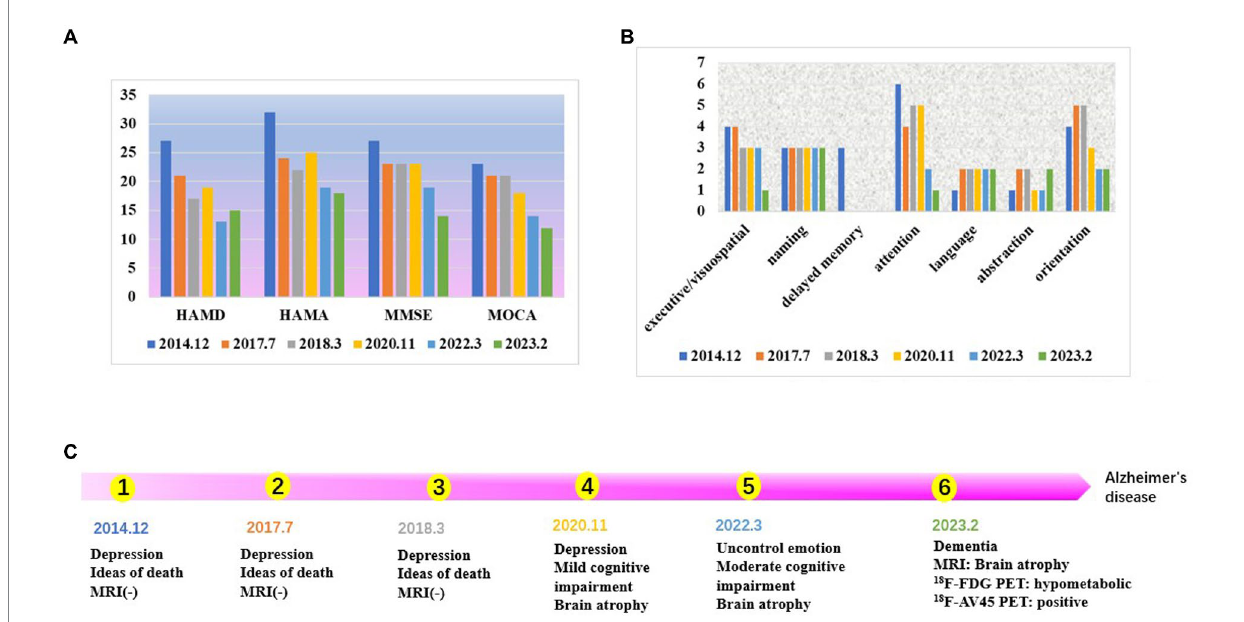
FIGURE 1 (A) The score of neuropsychological scale. The patient’s depression and anxiety scores, are decreasing. The scores for cognitive, dysfunction are increasing year by year. (B) The score of each cognitive domain in MOCA. Visuospatial/executive function, delayed memory, attention, and orientation are declined year to year. (C) Time line.